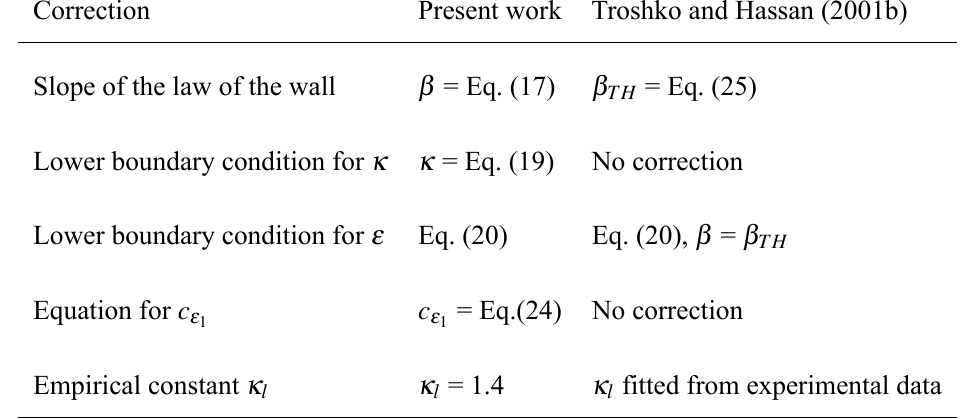
Summary of the corrections proposed to the single-phase κ − (cid:15) to account for the presence of bubbles and comparison with the formulation of Troshko and Hassan